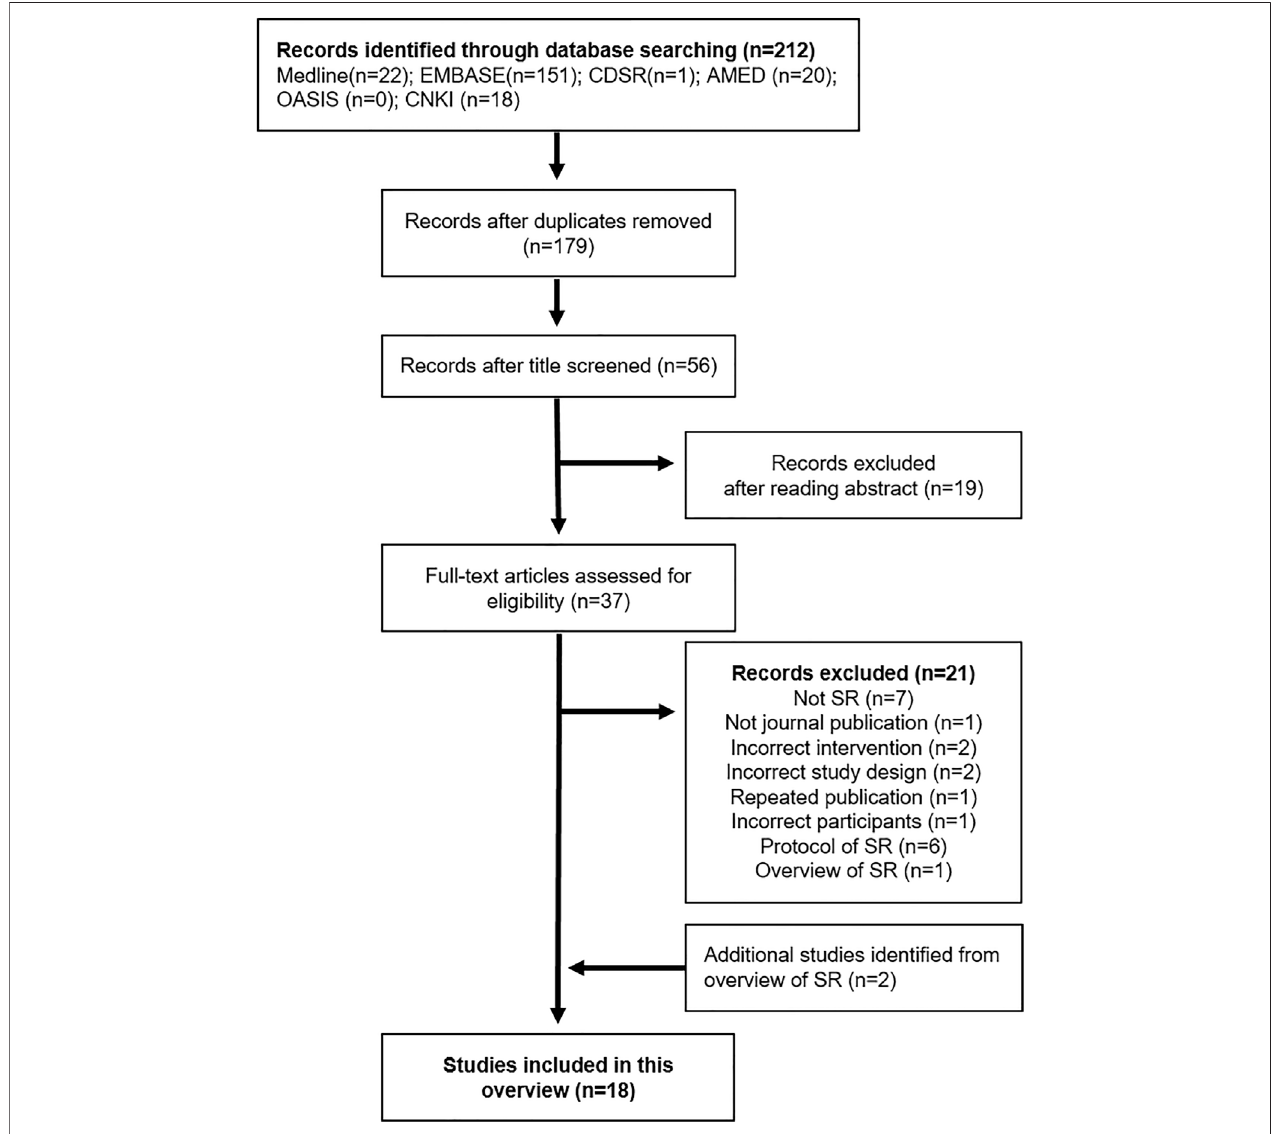
FIGURE1| Flowchartofthestudyselectionprocess.EMBASE:ExcerptaMedicadatabase,CDSR:CochraneDatabaseofSystematicReviews,AMED:Alliedand Complementary Medicine Database, OASIS: Oriental Medicine Advanced Searching Integrated System, CNKI: China National Knowledge Infrastructure database, SR: Systematic